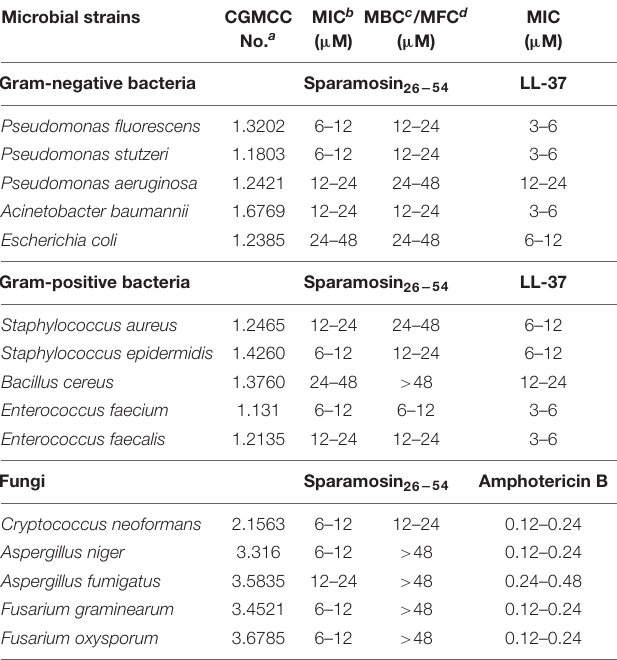
TABLE 1 | Antimicrobial activity of synthetic Sparamosin 26 − 54 . Microbial